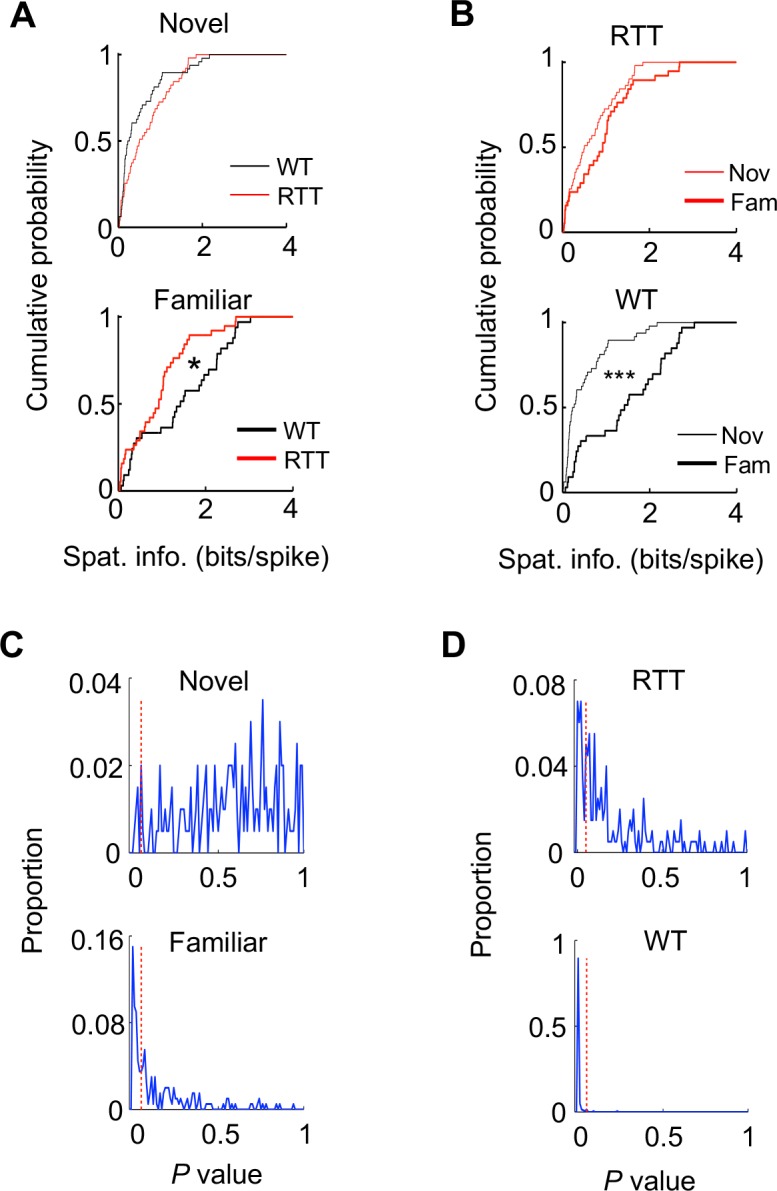
Place cells in RTT mice were impaired in experience-dependent increase in spatial information, after cells active on the novel and familiar tracks were down-sampled.The cells were randomly selected from the recorded cells active on the novel and familiar track in such a way that the number of cells was 31 for both genotypes (RTT, WT) on both the novel and familiar track. The random downsampling was repeated 200 iterations. (A) Cumulative distributions of spatial information for the down-sampled WT and RTT cells on the novel and familiar track in one example of iteration. Novel: p=0.096, Wilcoxon ranksum test comparing WT and RTT cells, number of cells by active trajectories: N = 51 (WT), 48 (RTT). Familiar: *p=0.026; number of cells by active trajectories: N = 38 (WT), 33 (RTT). (B) Same data as in (A), but comparing novel and familiar tracks for RTT and WT cells. RTT: p=0.15; WT: ***p=1.3×10−5. (C) Distribution of Wilcoxon ranksum test P values among all iterations for comparing spatial information between WT and RTT cells on the novel and familiar track. There were 3 and 42% of iterations producing a P value < 0.05 (red dashed line) on the novel and familiar track, respectively. The numbers suggest that the downsamping reduced the statistical power of comparing WT and RTT cells on the familiar track and therefore produced an insignificant P value for the originally significant comparison (Figure 2D) in many iterations. The downsampling largely did not affect the originally insignificant comparison between WT and RTT cells on the novel track (Figure 2B), because the number of down-sampled cells (31) was similar to the original number of WT cells (53) and RTT cells (31). (D) Similar to (C), but for P values among all iterations for comparing spatial information between the novel and familiar tracks for RTT and WT cells. There were 25 and 98% of iterations producing a P value < 0.05 (red dashed line) for RTT and WT cells, respectively. The numbers indicate that the vast majority of iterations showed significant increase in spatial information from the novel to familiar track in WT cells, but not in RTT cells, suggesting the experience-dependent increase in spatial information was impaired in RTT mice.